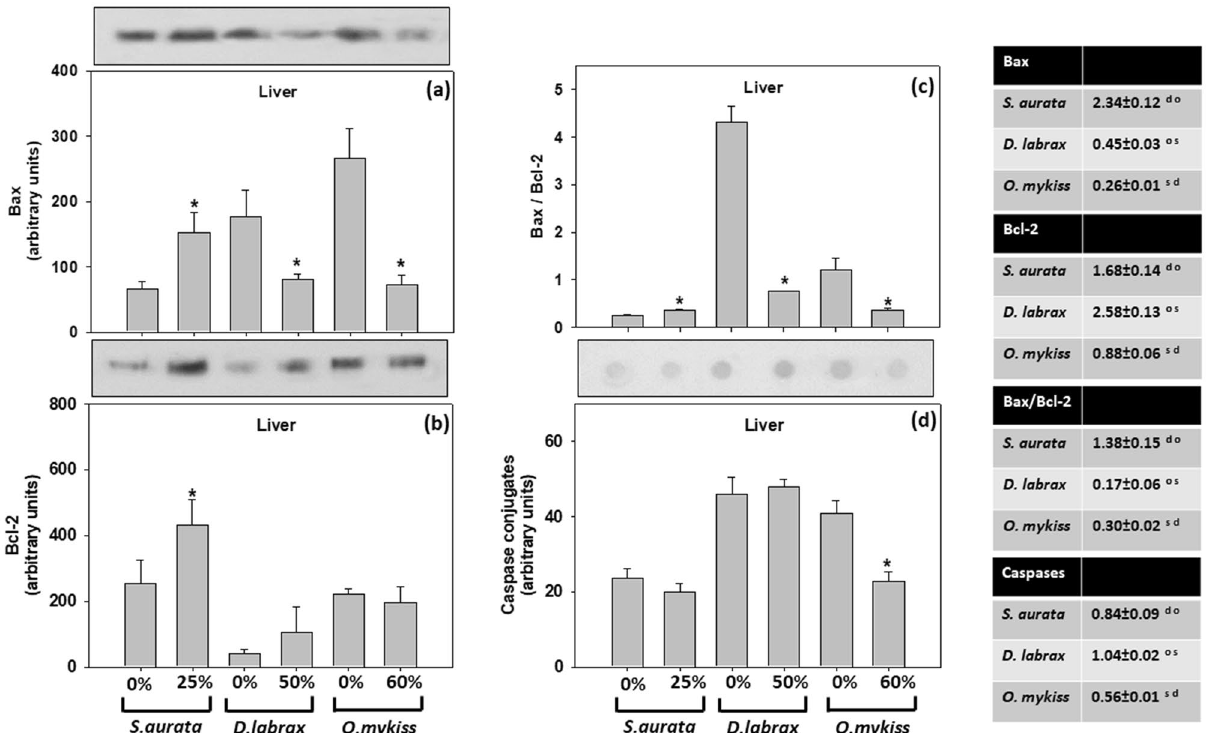
Figure 3. (a ) Bax, ( b ) Bcl-2, ( c ) Bax/Bcl-2 ratio and ( d ) caspases in the liver of gilthead seabream ( Sparus aurata ), European seabass ( Dicentrarchus labrax ) and rainbow trout ( Oncorhynchus mykiss ) under the 0–25%, 0–50% and 0–60% respectively inclusion of T. molitor (TM) meal. Representative immunoblots (Western blot for Bax and Bcl-2; Dot blot for caspases) are shown and were quantified by laser scanning [Gel-Pro Analyzer